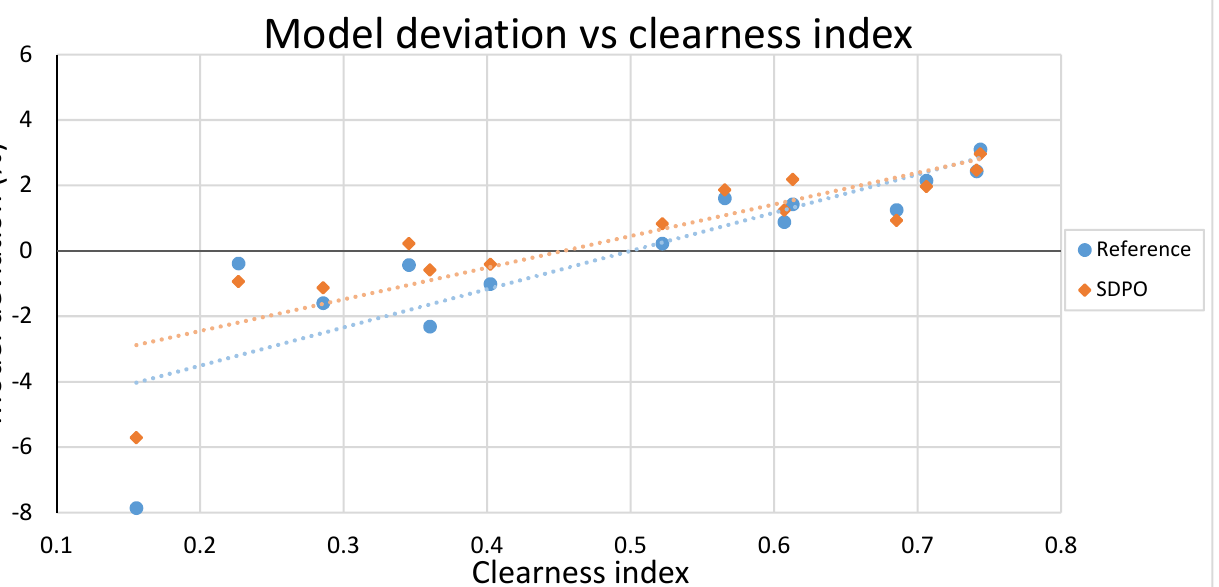
index above 0.6, the weather is classified as sunny.